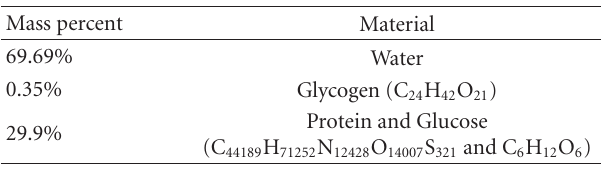
Table 1: The components and the structural materials of a liver tissue (relating to male sex).